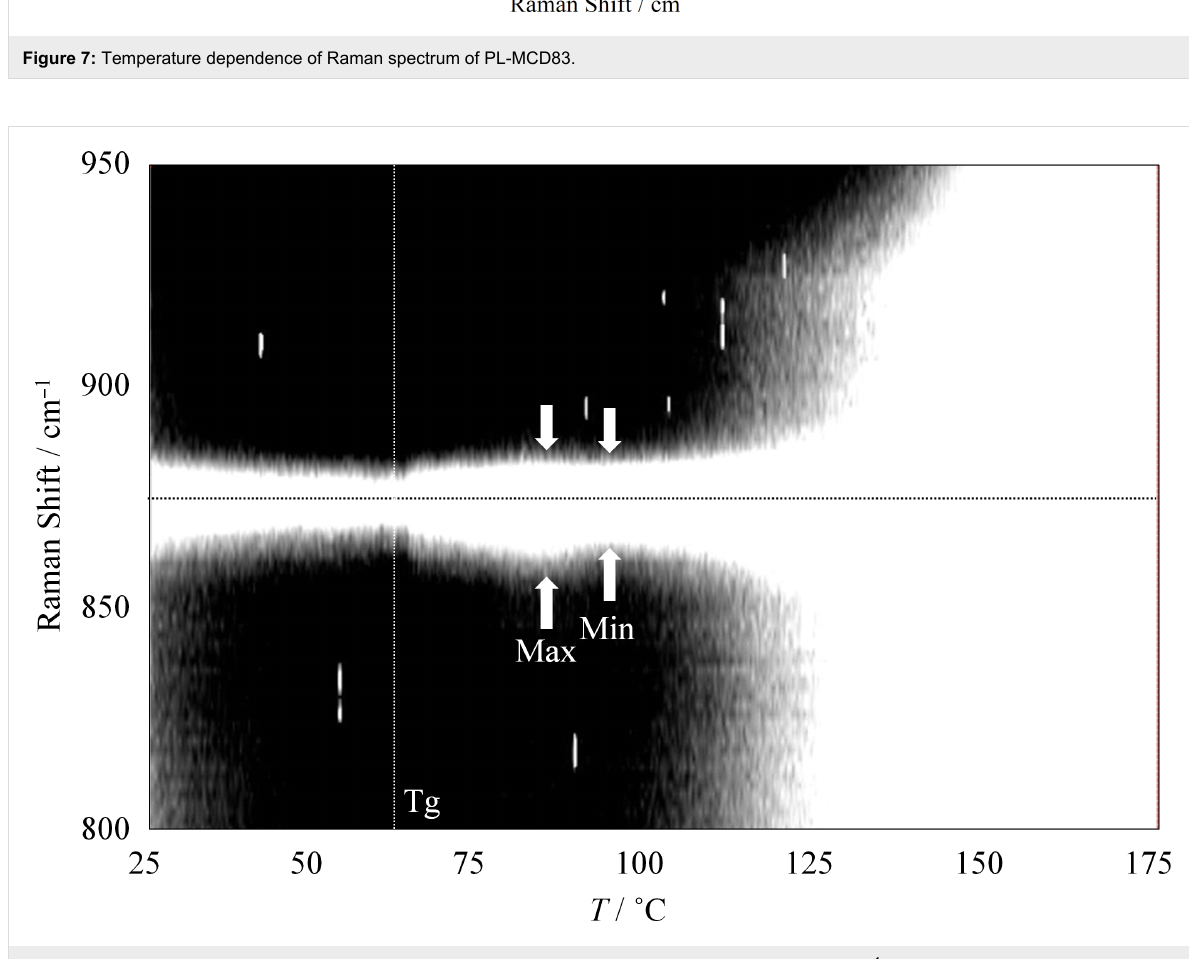
remains nearly constant or slightly decreases. Above the T g , the peak width increases and reaches a maximum at 80